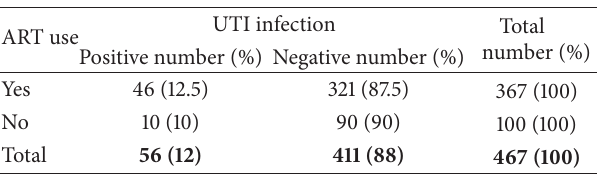
Table 1: Prevalence of urinary tract infection among ART and non- ART user patients, Jimma University Specialized Hospital, Ethiopia, 2012.